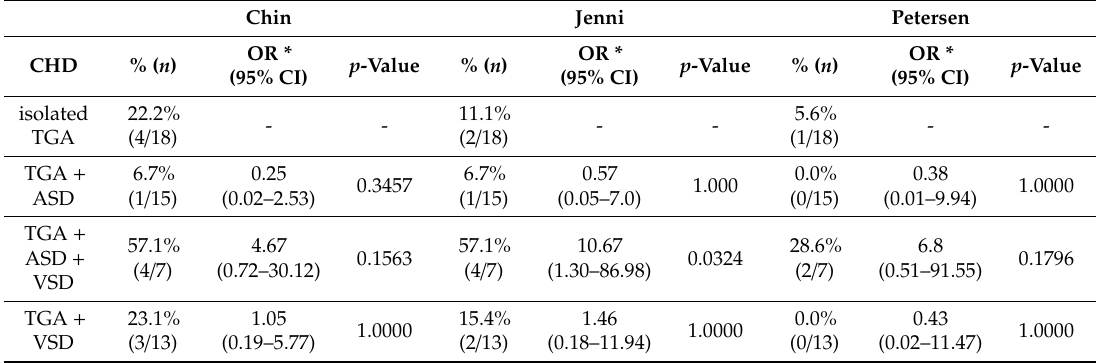
Table 6. Percentage of hearts presenting LVNC in TGA according to Chin, Jenni, and Petersen (apex). Chin